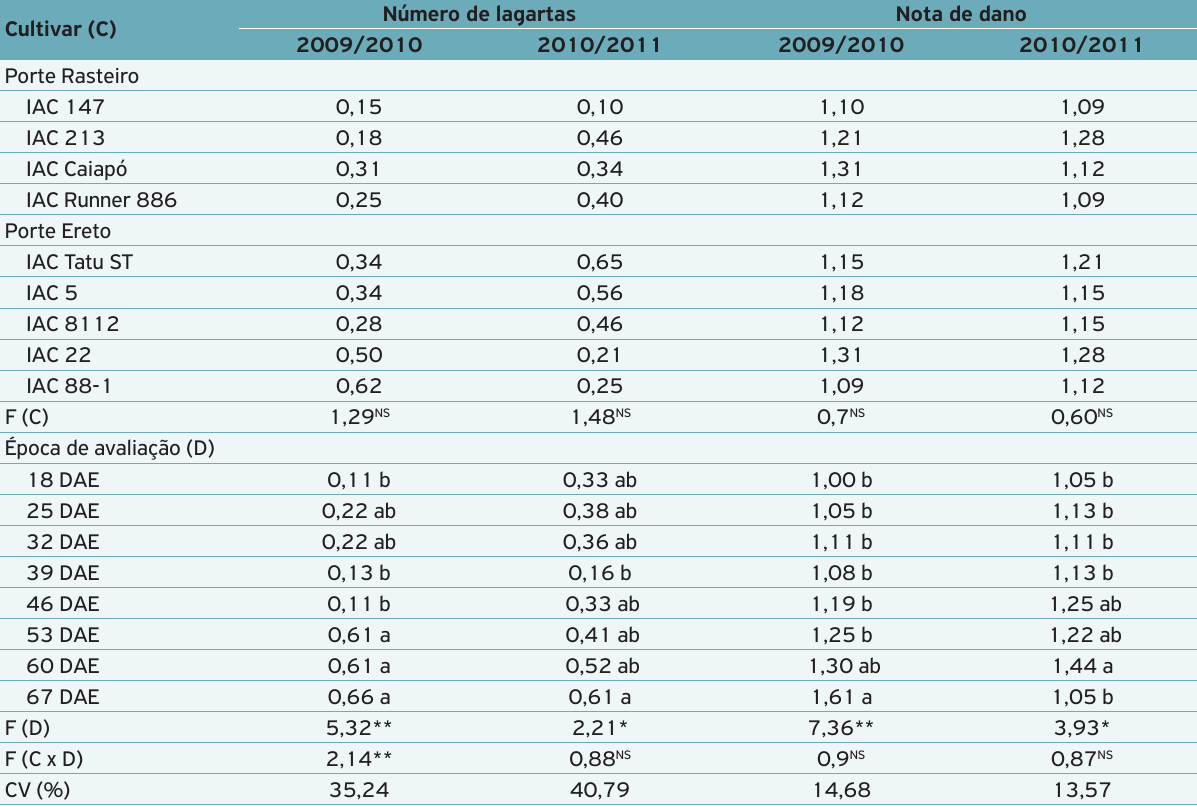
Tabela 1. Número e dano médio de Stegasta bosquella por folíolo em nove cultivares de amendoim, em oito épocas, durante o ciclo das plantas, sob infestação natural em campo. Urutaí (GO), 2009/2010 e